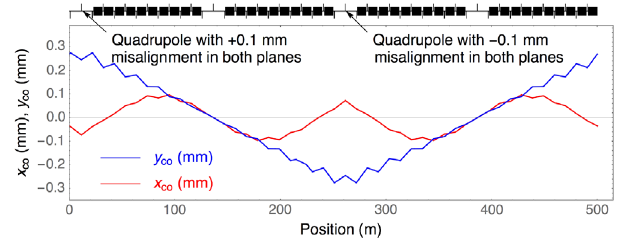
rad.FIG. 4. Vertical and horizontal closed orbit with two quadru- pole misaligned by 100 μ m in both